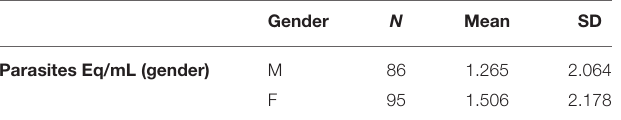
N, number; SD, Standard